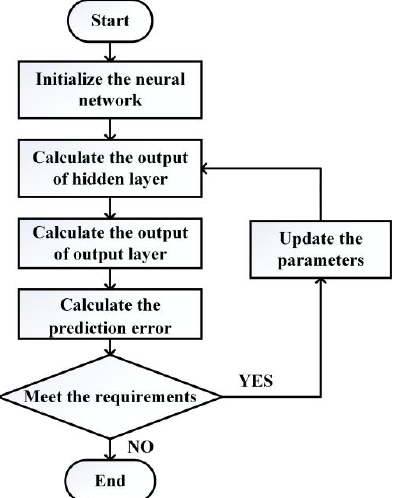
Figure 4. Training flowchart of the neural network.